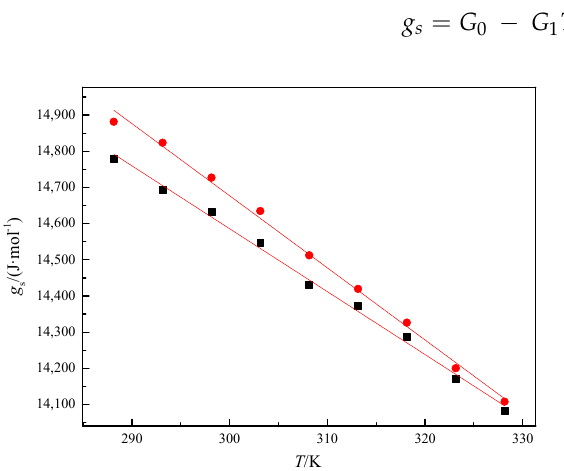
Figure 2. Molar surface Gibbs energy ( g s ) plotted against temperature ( T ). [C 1 OC 2 mim][Ala]: g s = 19803 − 17.39 T , r 2 = 0.995, sd = 16.4; [C 2 OC 2 mim][Ala]: g s = 20658 − 19.94 T , r 2 = 0.996, sd = 17.5. G 0 and G 1 for [C n OC 2 mim][Ala]( n = 1,2) are obtained from Figure 2 and substituted